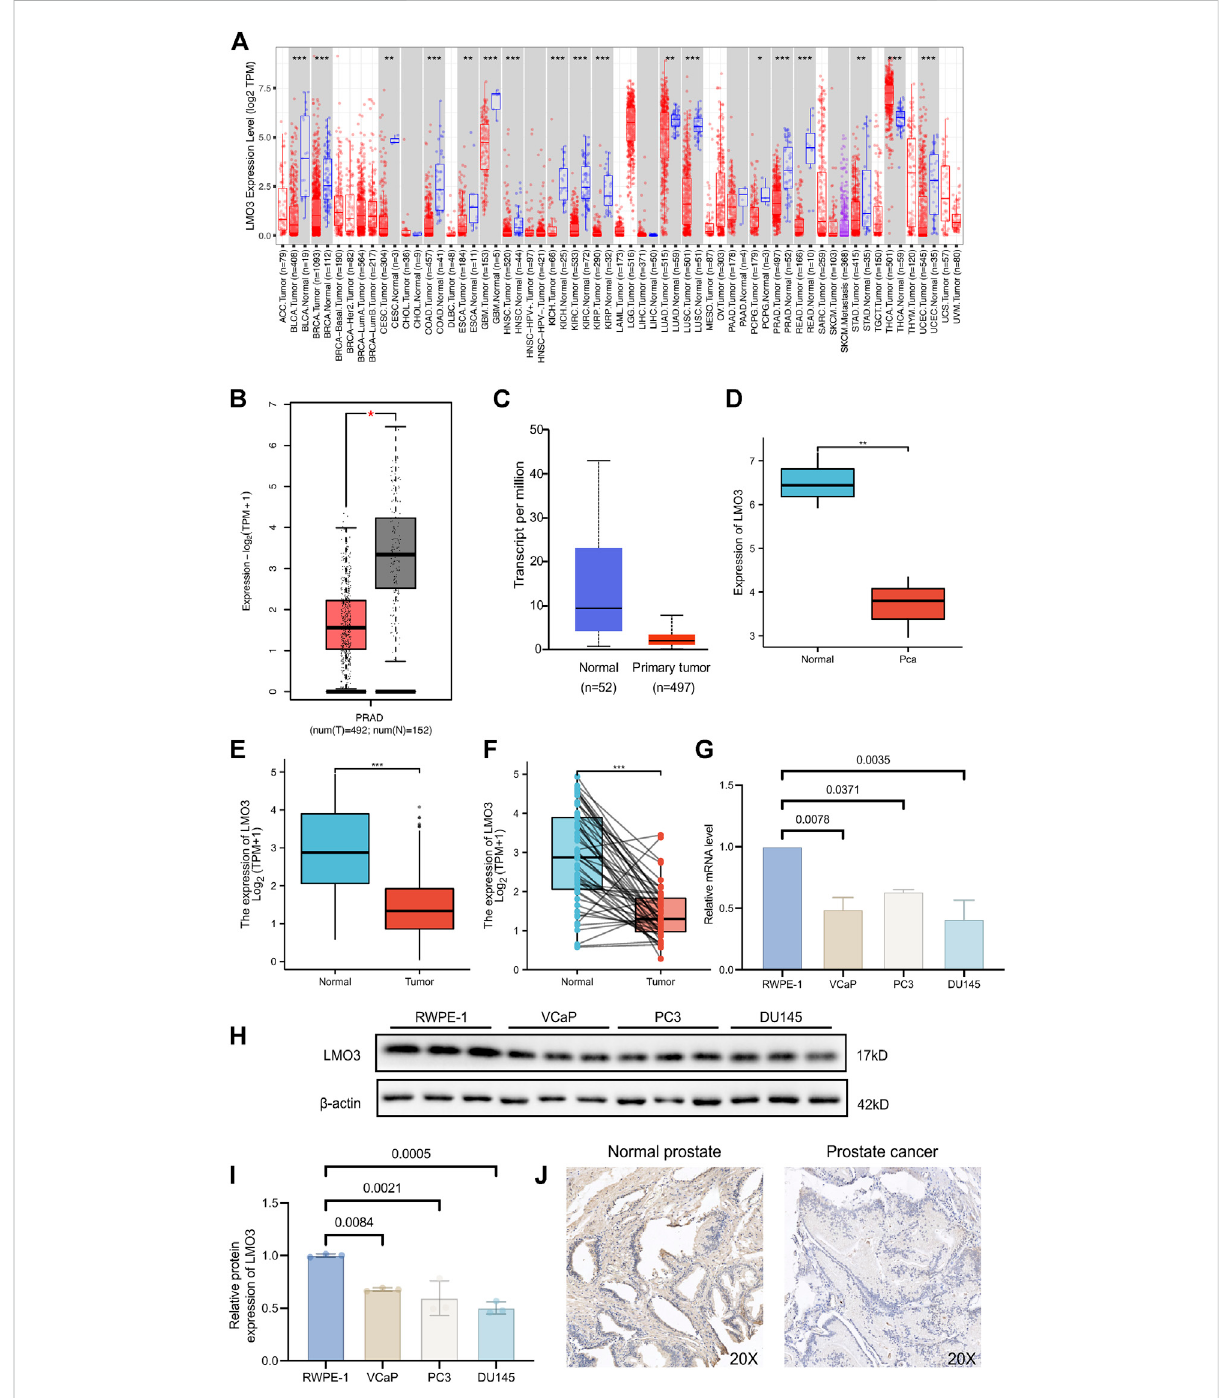
FIGURE 1 Expression of LMO3 in prostate cancer. (A) LMO3 expression in different types of cancer was investigated with the TIMER database. (B) Decreased expression of LMO3 in prostate cancer compared to normal tissues in the GEPIA database. (C) LMO3 expression in prostate cancer was examined by using the UALCAN database. (D) LMO3 expression in prostate cancer was examined by GSE30994. (E) Analysis of LMO3 expression in prostate cancer and adjacent normal tissues in TCGA database. (F) TCGA database and statistical analyses of LMO3 expression in 52 pairs of PRAD tissues and adjacent normal tissues. (G) LMO3 expression in four different cell lines was examined by qPCR. The mean ± s.d. is shown. (H) Representatve immunoblot and (I) semi-quanti fi cation of LMO3 protein expression in four different cell lines (J) Immunohistochemical staining of LMO3wasperformedinprostatecancerandnormalprostatetissues.Representativeimagesareshown.Statisticalsigni fi cancewasdeterminedusing one-way ANOVA with the post hoc Tukey test. * p < 0.05, ** p < 0.01, and *** p <